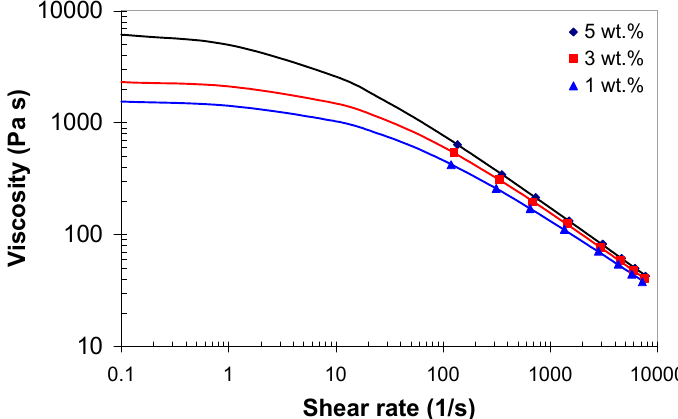
Figure 5. Melt shear viscosity of EVA/MWCNT composite as a function of shear rate at 160 °C (Solid line represents the prediction based on the Cross model).